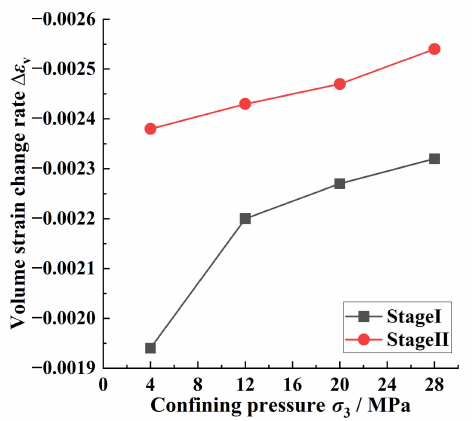
Figure 5. Variation rate of volumetric strain with confining pressure from yield point to peak point. Stage I is the stage from the yield point to the expansion point; Stage II is the stage from the expansion point to the peak